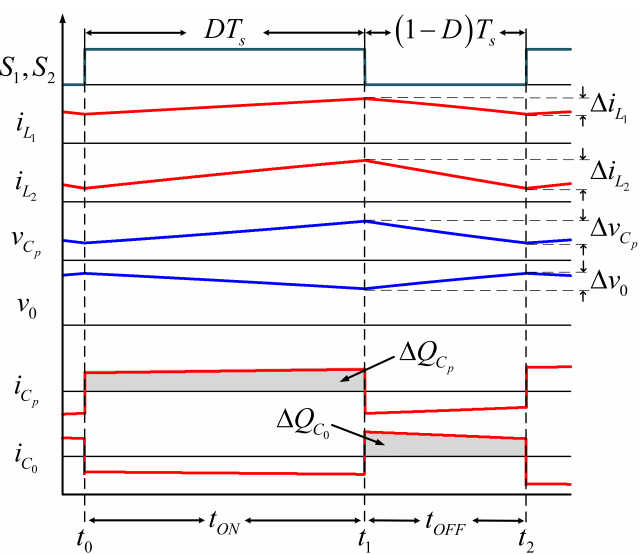
Figure 7. Current and voltage waveforms of the converter in the time T s